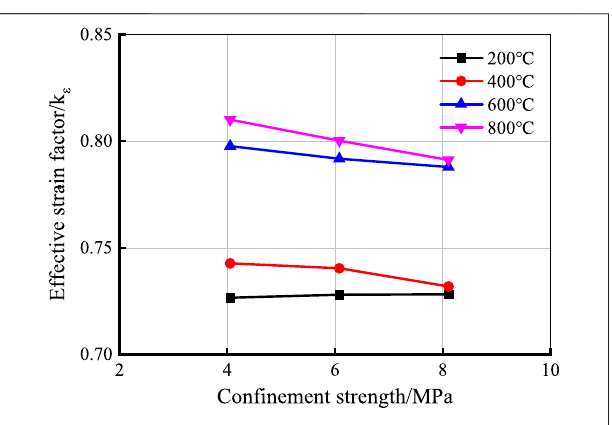
FIGURE 7 | BFRP ef fi ciency factor versus historical high temperature.